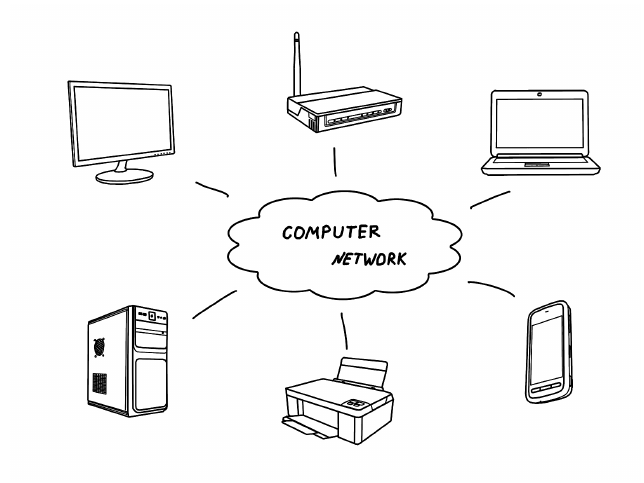
Figure 2. A common network architecture, adapted from